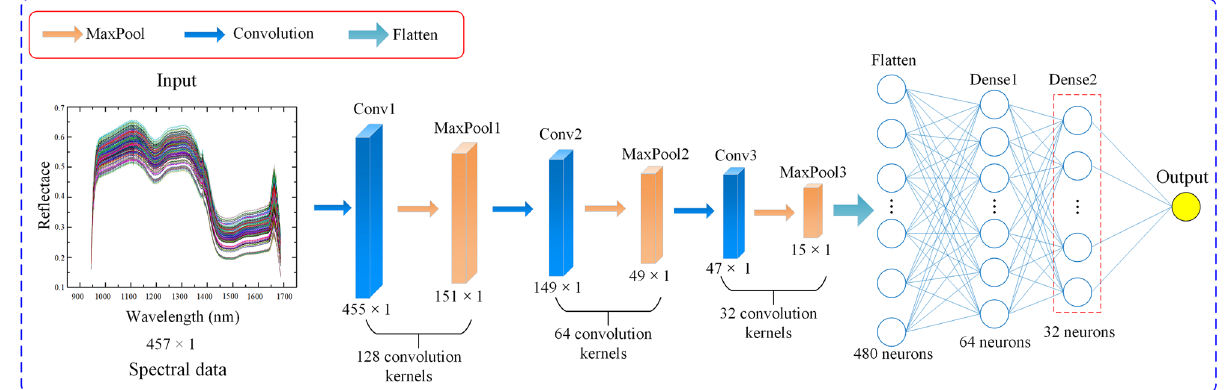
Figure 1. The Structure of 1D-CNN.